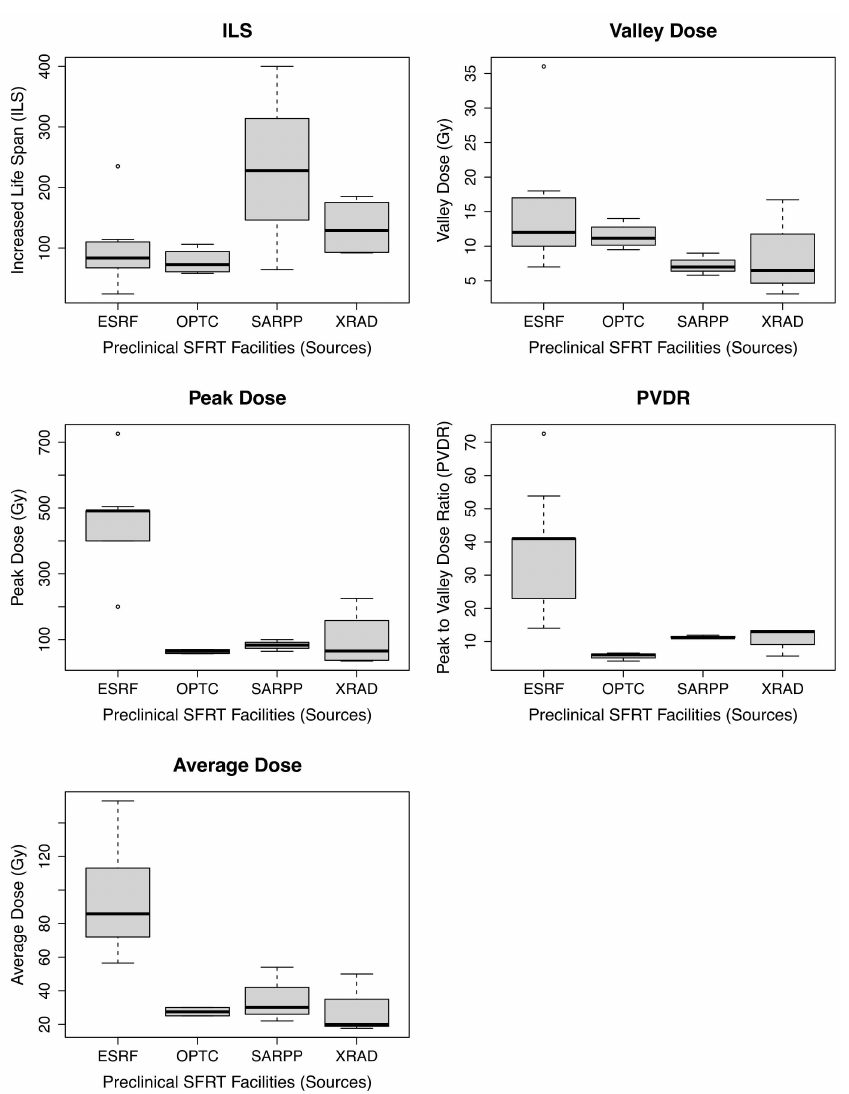
Figure 2. Comparative distribution of the data among radiation facilities. No statistical analysis was performed. RStudio was used to create these